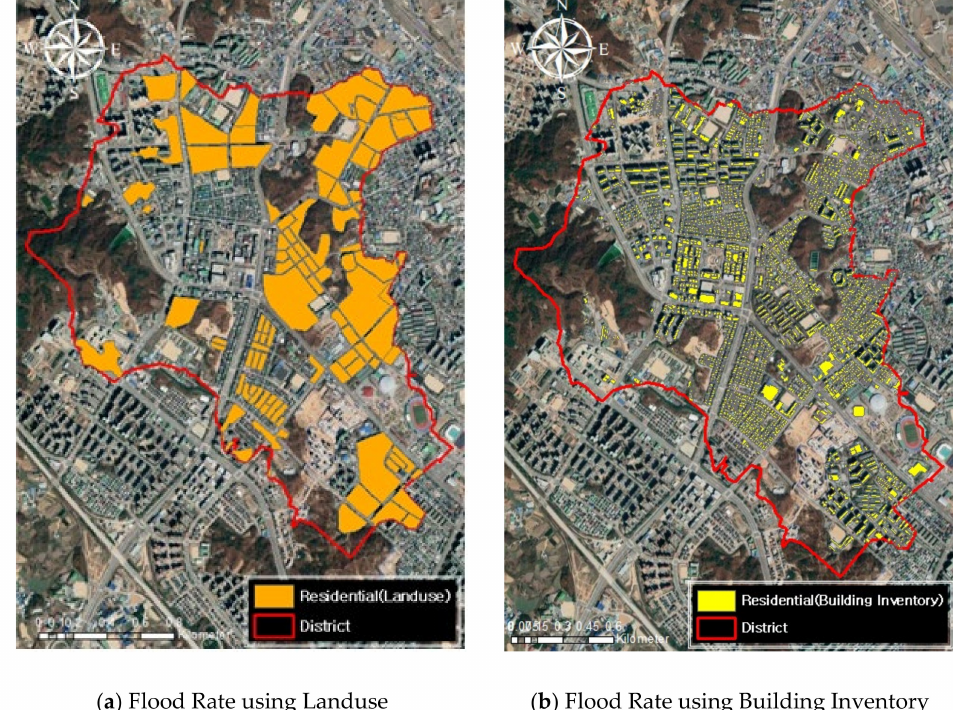
Figure 4. Comparison of Estimate Flood Damage Rate.